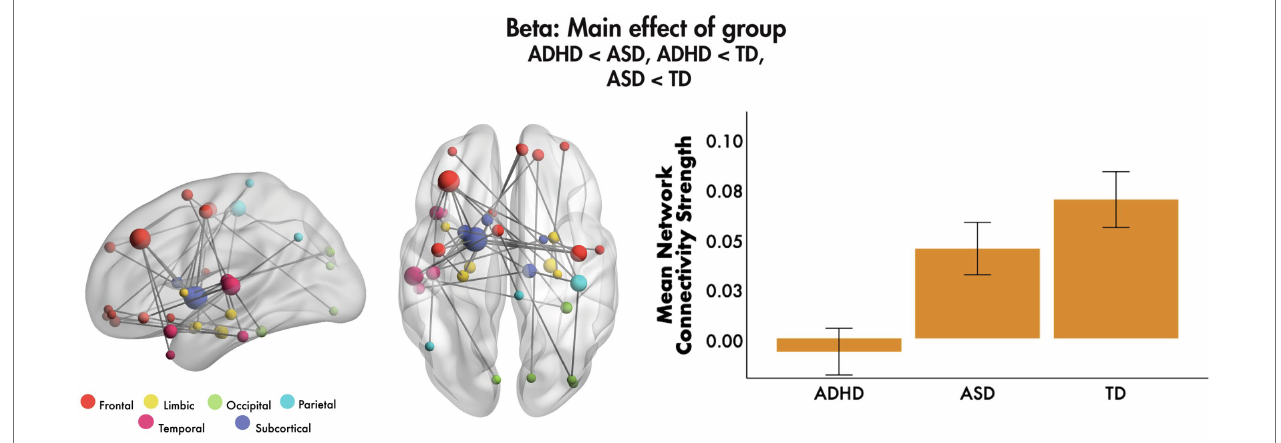
FIGURE 2 | Main effect of group, 200–400 ms to emotional faces, following the onset of non-target trials. A significant main effect of group was observed in the beta frequency range to emotional faces. The glass brains represent the network, where node size is scaled by degree. The mean network connectivity strength is plotted for each group in the bar graph (error bars represent 95% confidence intervals).